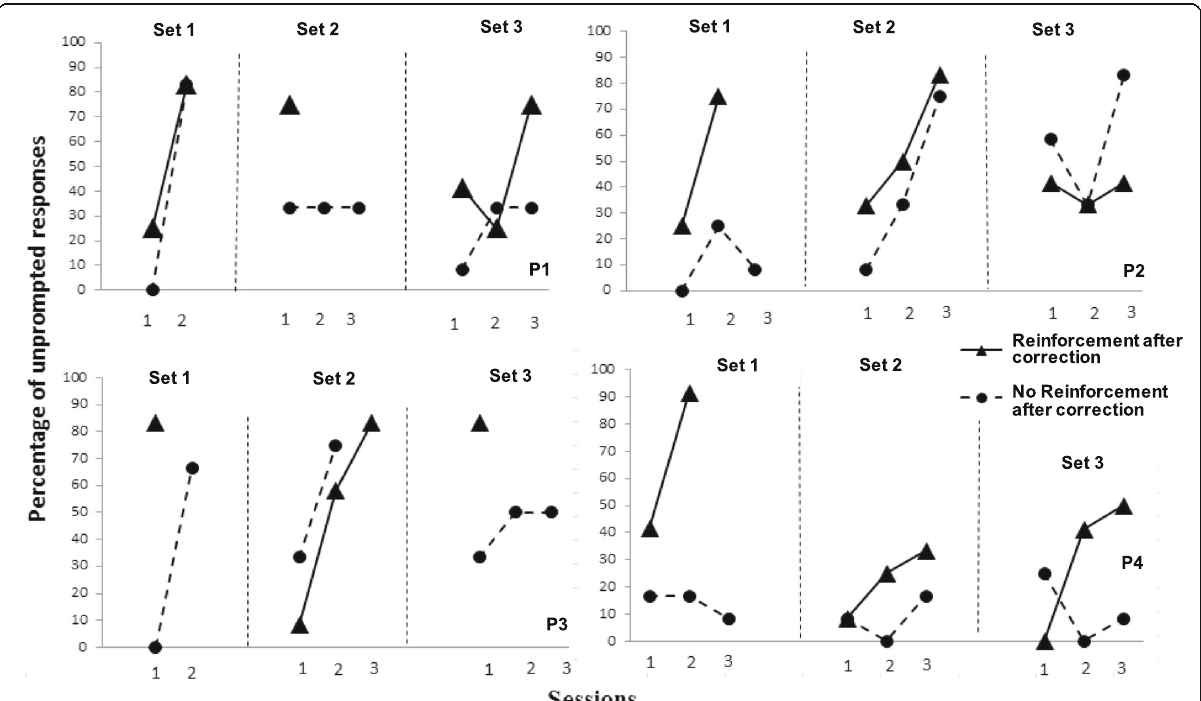
Fig. 3 Percent unprompted correct responses per session for three trained sets of tacts (set 1, set 2, and set 3) for each participant (P1, P2, P3, and P4), during training sessions with delayed echoic prompts, with and without reinforcement for correct answers after correction procedures Endnotes 1 Tact: A verbal operant controlled by non-verbal antecedent stimuli and maintained by generalized reinforcement (Skinner, 1992).